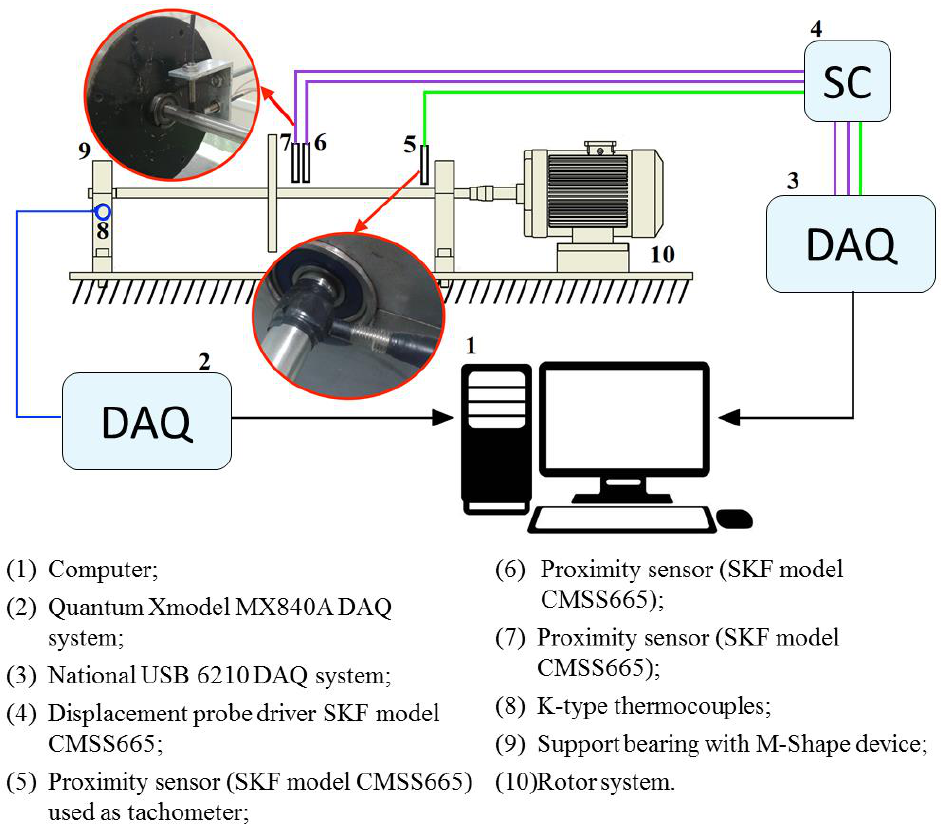
Figure 10. Sketch of the rotor system coupled with a sensor. Experiments were performed under three experimental conditions — i.e., without and with preloads of 1.0 mm and 1.5 mm in the support bearing with the M-Shape device. An acceleration from 0 to 50 Hz over 500 s (0.1 Hz/s) was applied to the rotor system. This acceleration was chosen because the system should not pass through its natural frequency quickly, which can be a solution to avoid high amplitudes. The average results were ob- tained in five experiments for each preload.